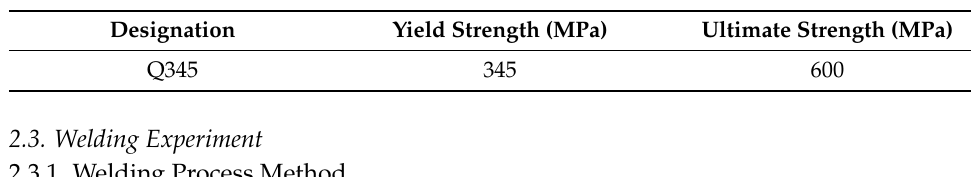
Table 2. Mechanical properties of Q345 steel.